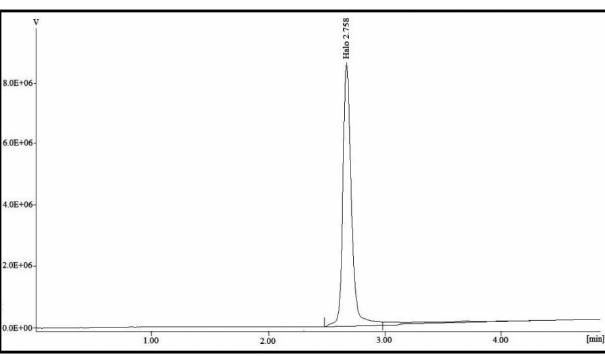
FIGURE 3 - HPLC chromatogram of